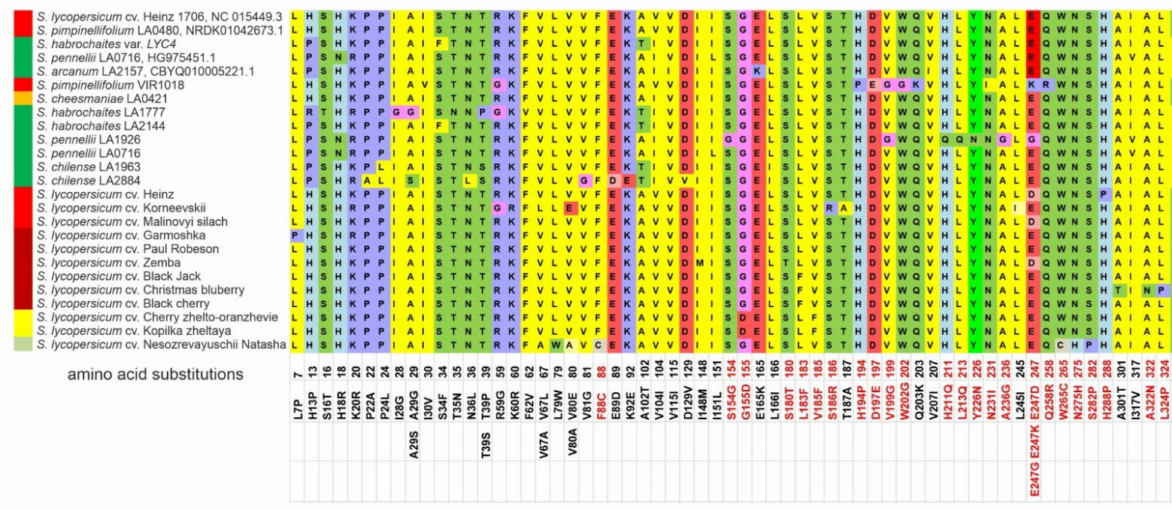
Figure 2. Polymorphisms in tomato Z-ISO homologs. The numbers indicate the positions of single nucleotide polymor- phisms (SNPs) in the Z-ISO coding sequences (exons I–IV) relative to S. lycopersicum Z-ISO ; the resulting aa substitutions in the translated Z-ISO proteins are shown below. Nonsynonymous SNPs and PROVEAN-predicted radical aa substitutions are marked red. Ripe fruit color is indicated to the left of the accession